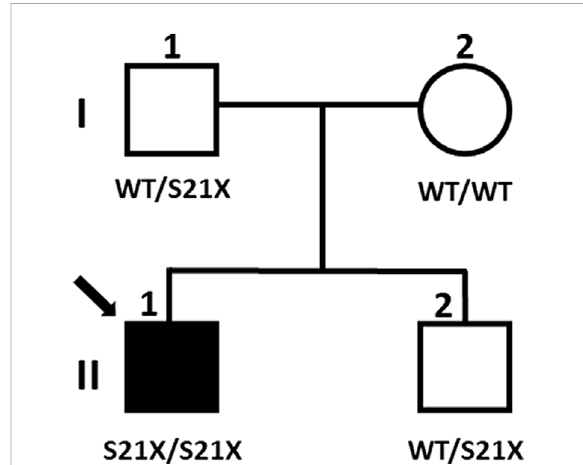
FIGURE 2 Segregation of the mutation in the family. Filled symbols representaffectedindividuals,andthearrowindicatestheproband subjectofthisstudy(individualII:1).Genotypesareindicatedbelow the